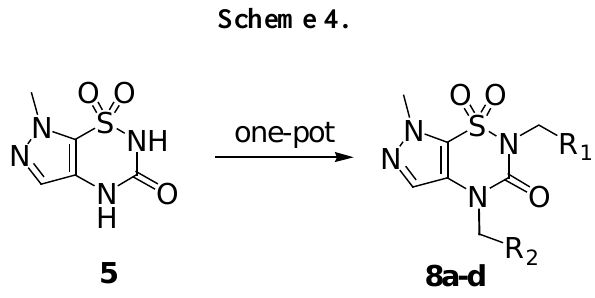
, N -substituted-7-methylpyrazolo[4,5-e][1,2,4]thiadiazine-3(2 H ,4 H )-one Table 3. N 2 4